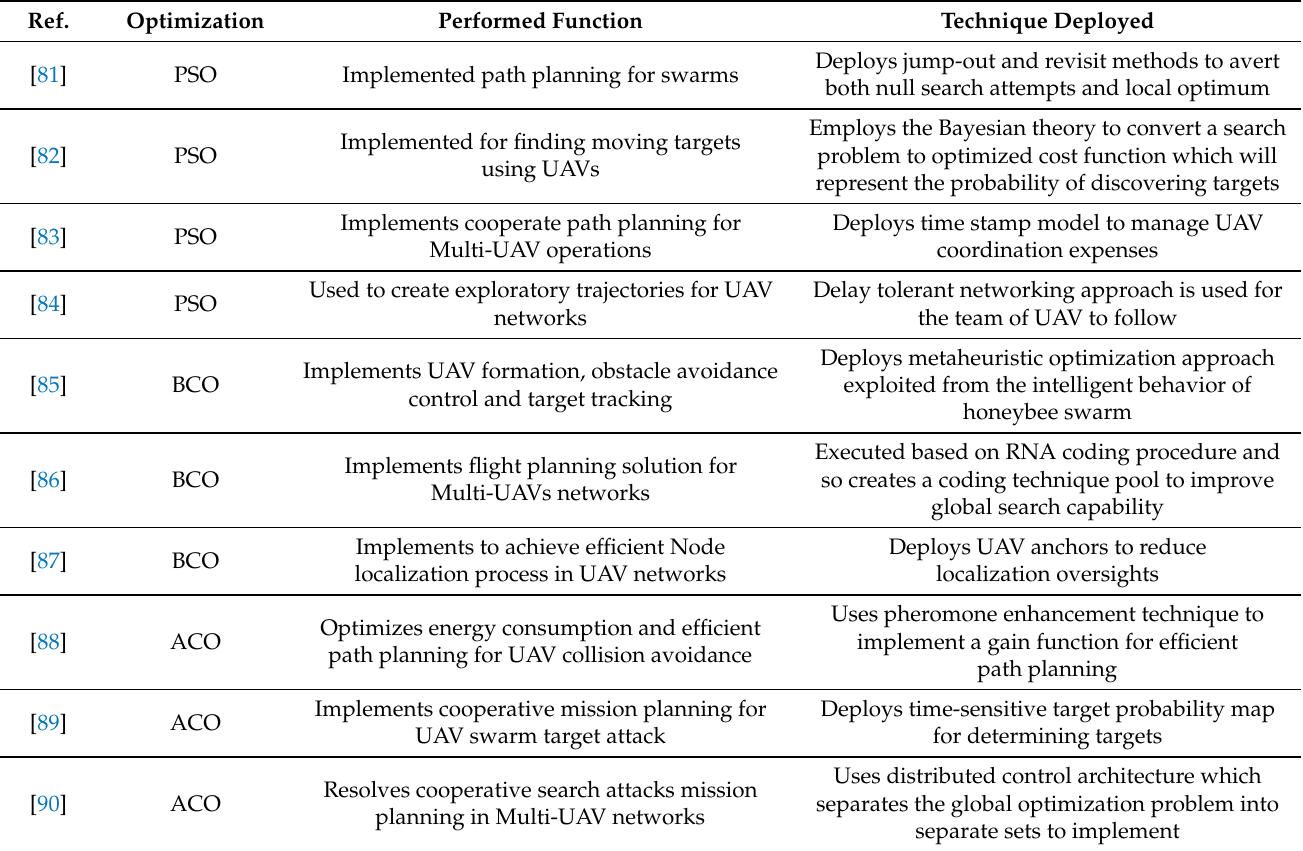
Table 3. Optimization-based